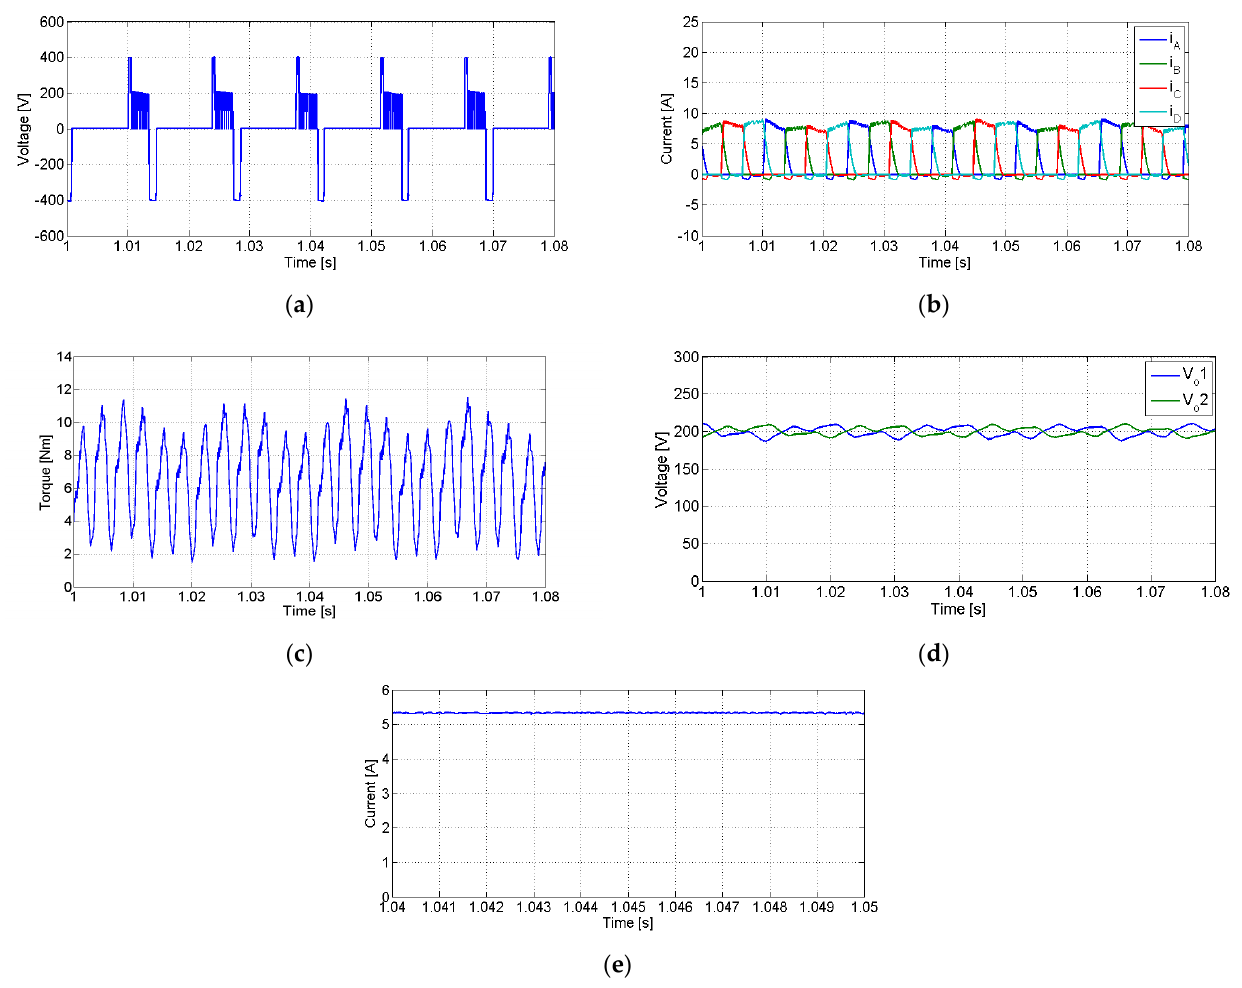
Figure 7. Obtained simulation waveforms for the tests in which an irradiance of 700 W/m 2 and an ambient temperature of 25 °C associated with the motor drive were defined: ( a ) motor winding A applied voltage, ( b ) currents in the motor windings, ( c ) SRM torque ( d ) input DC voltages applied to the drive, ( e ) converter input current.